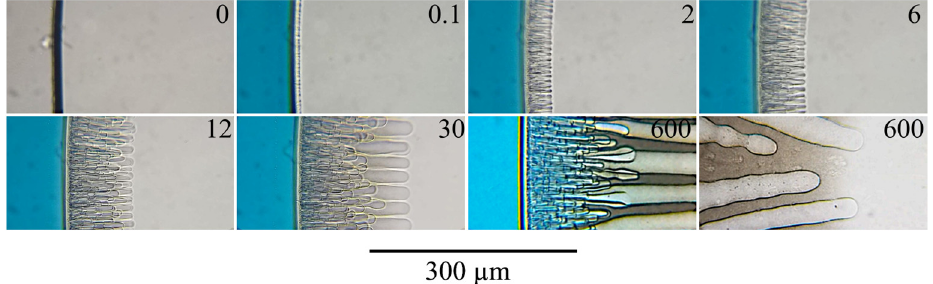
Figure 7. The evolution of the structure of a mixture of PAN with DMSO containing 15 wt.% of polymer in contact with water. The time in seconds from the moment of contact between the sample and the non-solvent is indicated in the upper right corner of each photo.